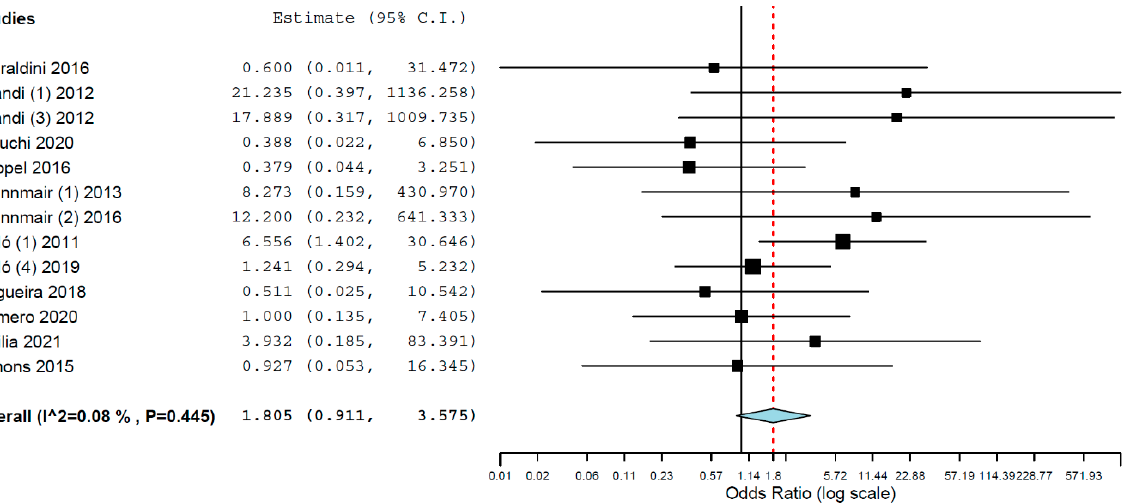
Figure 3. Forest plot for the event ‘implant failure’, studies evaluating implants inserted exclusively in maxillae.